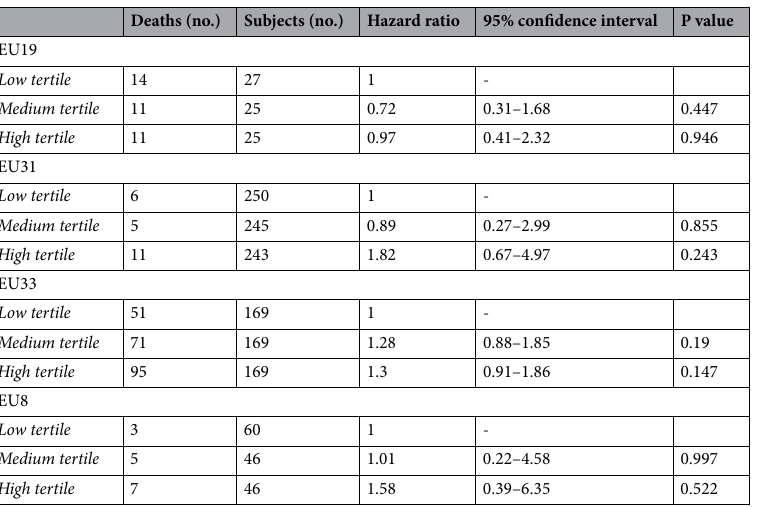
Table 5. Mortality risk by laboratory and tertile of DNA damage measured with the comet assay (composite endpoint). Laboratories with at least 10 deaths were considered. The hCOMET cohort. Estimates adjusted for age, sex, smoking habit, and occupational exposure.